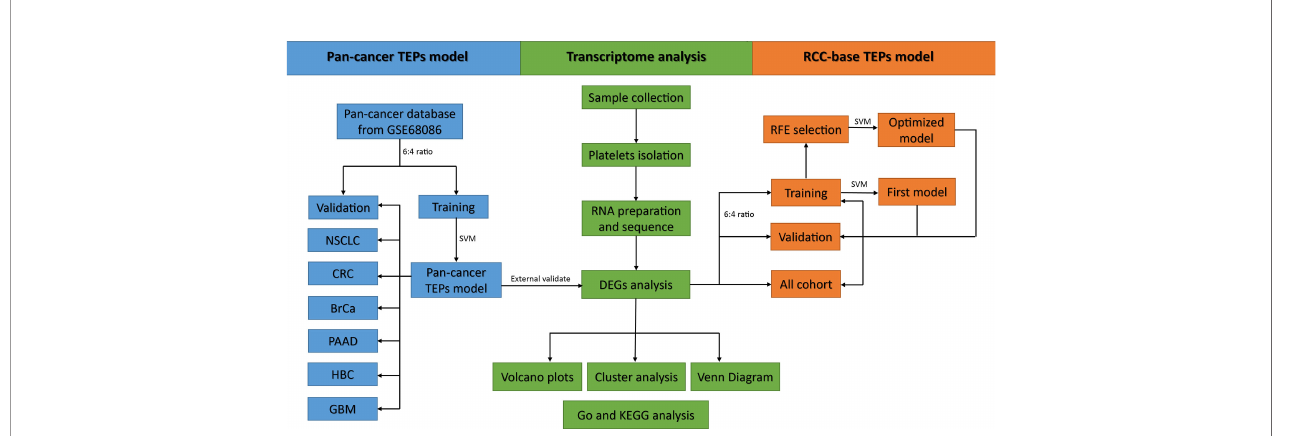
FIGURE 1 | Flowchart of the main analytic steps in our